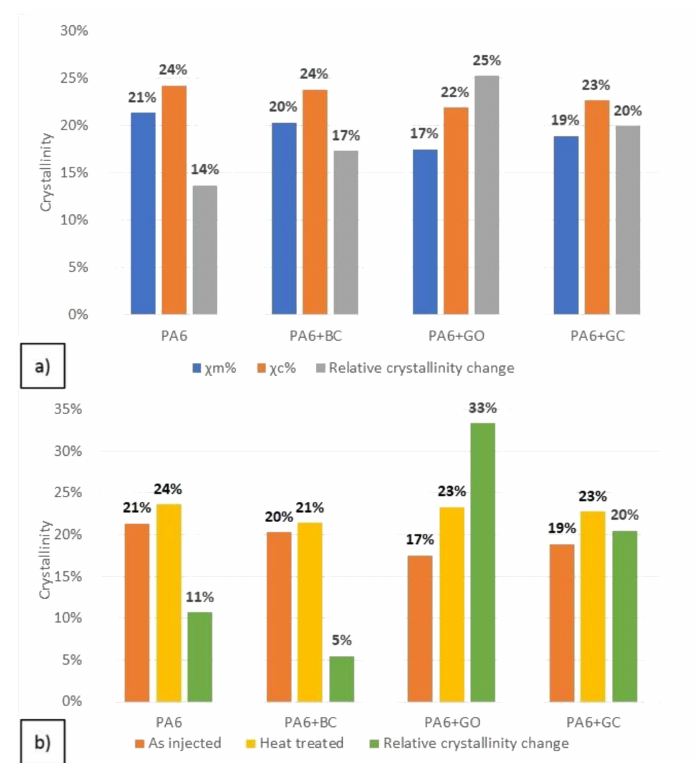
Figure 6. Crystallinity calculation results: crystallization upon cooling in the DSC ( a ), crystallization changes after heat treatment ( b ).